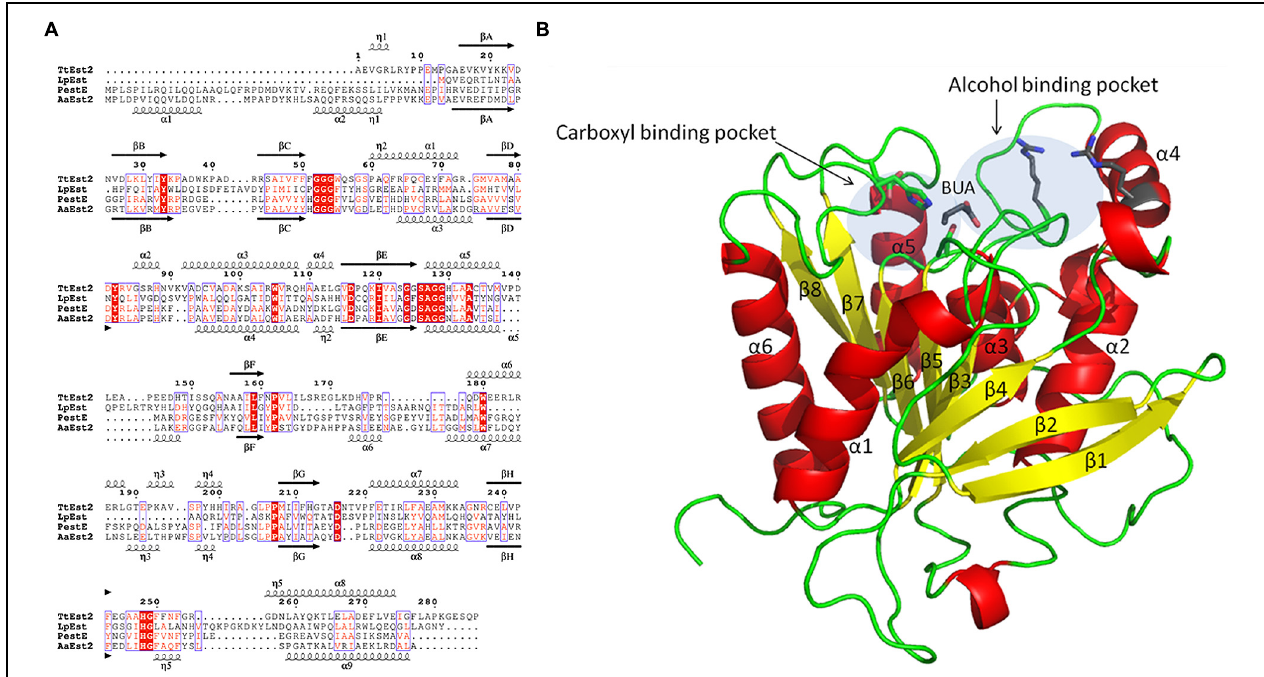
FIGURE 2 | (A) Amino acid sequence alignment of TtEst2, LpEst, PestE, and AaEst2 shown with the secondary structure elements indicated above and below the sequence for TtEst2 and AaEst2 enzymes. Spirals and arrows represent α -helices, η -3 10 helices and β -strands, respectively. The secondary structure assignments were carried out and the figure was produced using ESPript (Robert and Gouet, 2014). Conserved residues are shown in red boxes, and residues with similar properties are in blue boxes. (B) Folding of the TtEst2 monomer presented as a cartoon diagram. The residues of the catalytic triad are shown as stick model with carbon atoms in green, the butyrate ligand (BUA) which maps the carboxyl binding pocket is shown with carbon atoms in gray, arginine residues at the far end of alcohol pocket are shown with carbon atoms in gray. The two transparent boxes outline the carboxyl and the alcohol binding pockets. Figures 2B , 3 , and 4 were prepared using PyMol (DeLano, 2002).